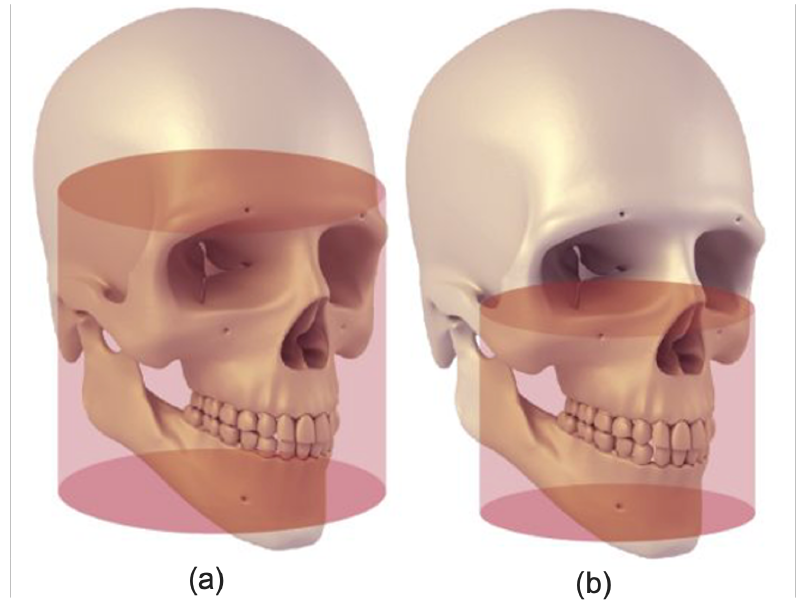
Figure 1. Field of views (FOVs) representing ( a ) Large FOV (140 mm × 165 mm) and ( b ) Medium (80 mm × 100 mm) (Figure Credit: